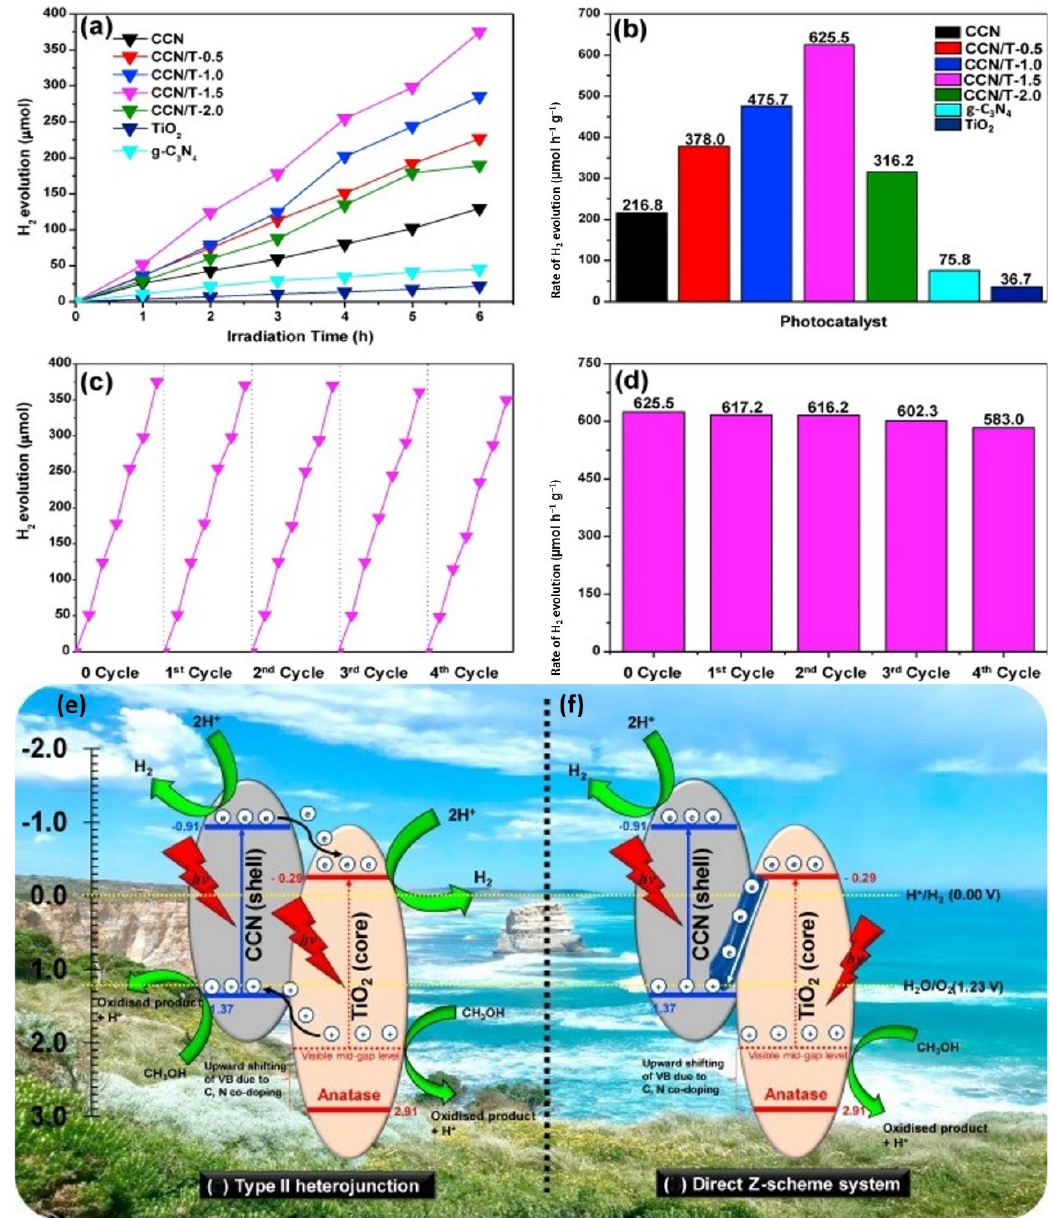
Figure 14. ( a ) photocatalytic hydrogen production rate; ( b ) photocatalytic hydrogen evolution efficiency comparing several photocatalysts. ( c , d ) photocatalytic consistency and photocatalytic H 2 generation frequency over CCN/T-1.5 for four cycles. During simulated solar exposure, a schematic representation of the photocatalytic process of CCN/T-1.5 photocatalysts is shown. Type II heterojunction ( e ) and Direct Z-scheme system ( f ). Reprinted with permission from Ref. [123]. Copyright 2019, copyright Elsevier.